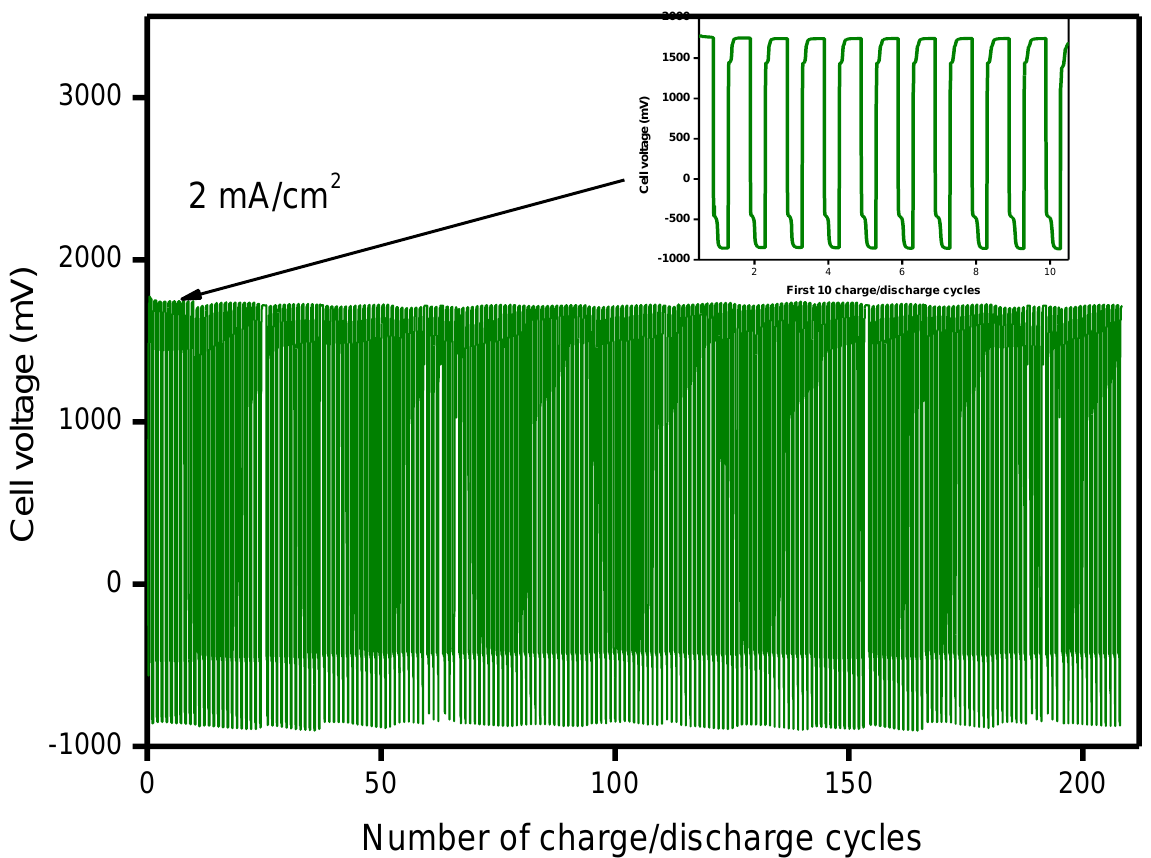
Figure 5. Charge/discharge cycling of third-generation zeolite-based AE at: charge time 45 min; discharge time 30 min; current density: ± 2 mA/cm 2